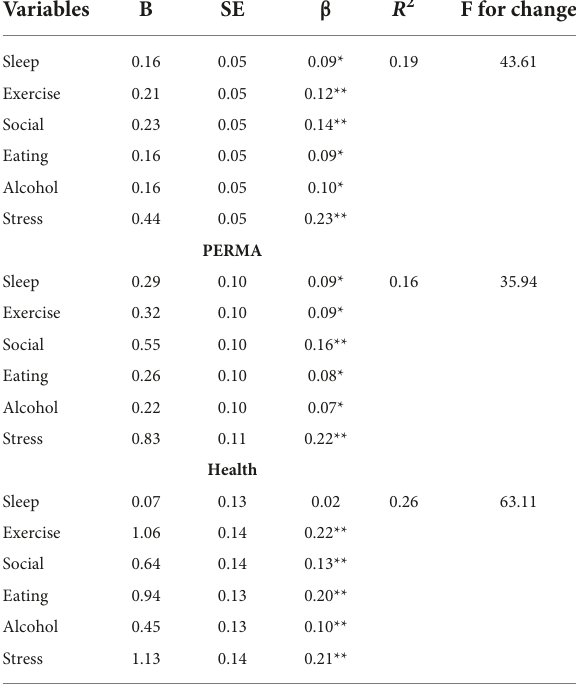
TABLE 3 Multiple regression models to assess the ability of lifestyle medicine (LM) pillars to predict variance in wellbeing using mental health continuum (MHC), PERMA, and physical